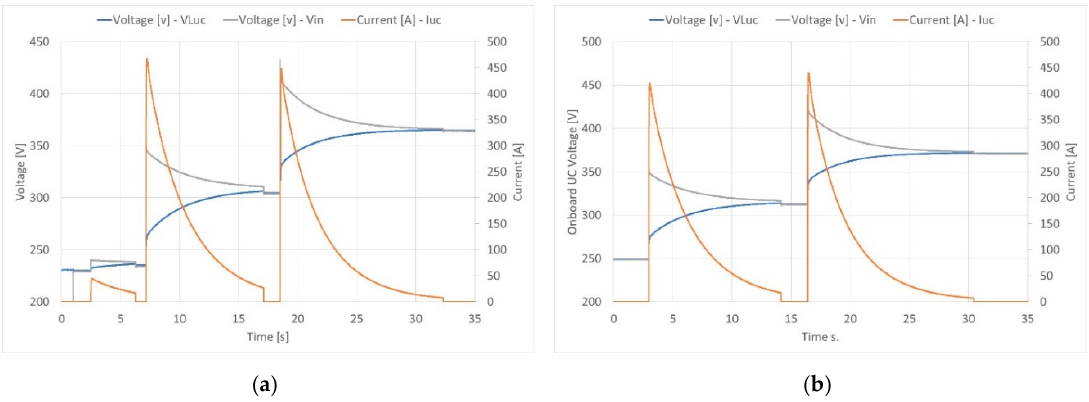
Figure 7. Charge process with onboard initial voltage of: ( a ) 230 V, ( b ) 250V.